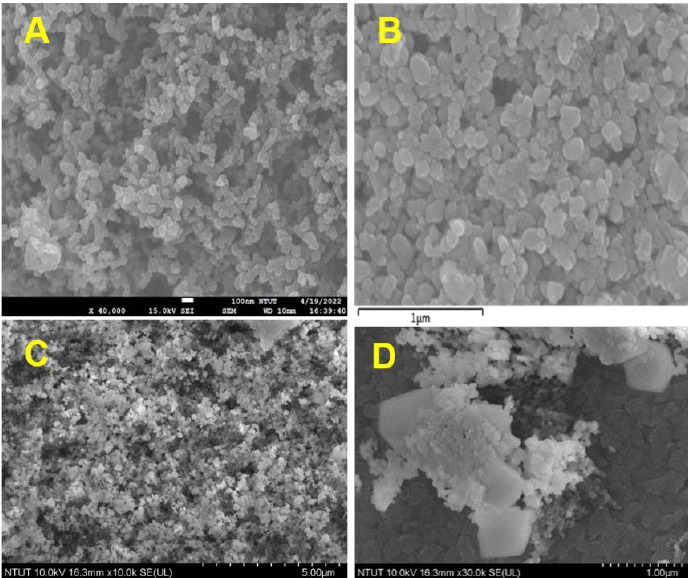
Figure 1. ( A ) FE-SEM image of CB; ( B ) ZnWO 4, ; and ( C , D ) ZnWO 4 /CB composite.